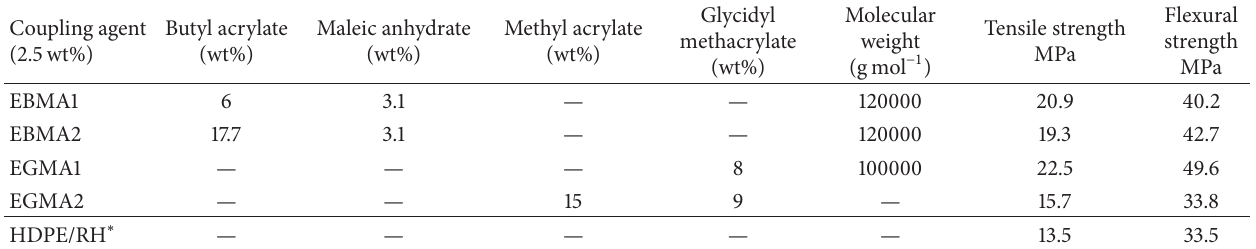
Table 6: Interrelation between chemical compositions of coupling agents and mechanical strength of HDPE/RH (32.5 :65 wt%) composites [19].